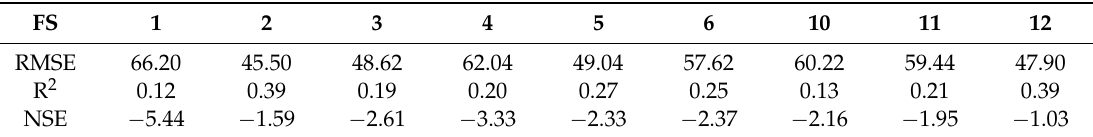
Table 4. Validation of MLC results with dive transect mappings per flight stripe